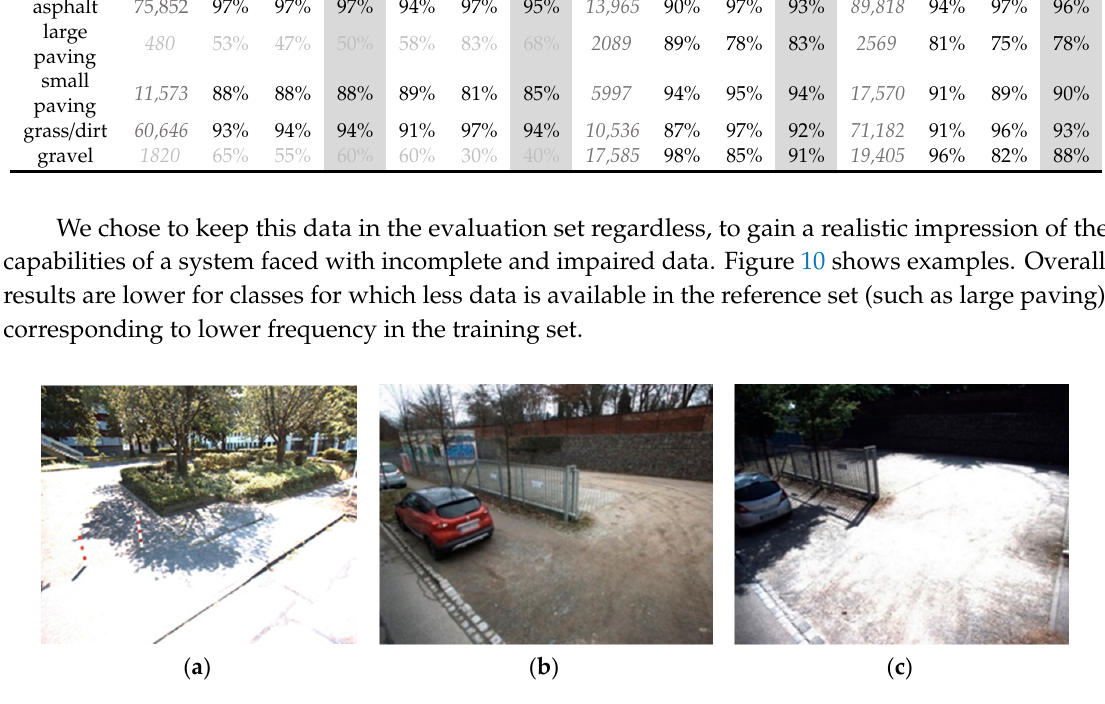
Figure 8. ( a ) Paved surface, strongly overexposed. Variation of input data quality due to different lighting conditions. Images show the same gravel surface recorded in ( b ) spring and ( c ) summer. Visibility is not improved in the following and preceding images.